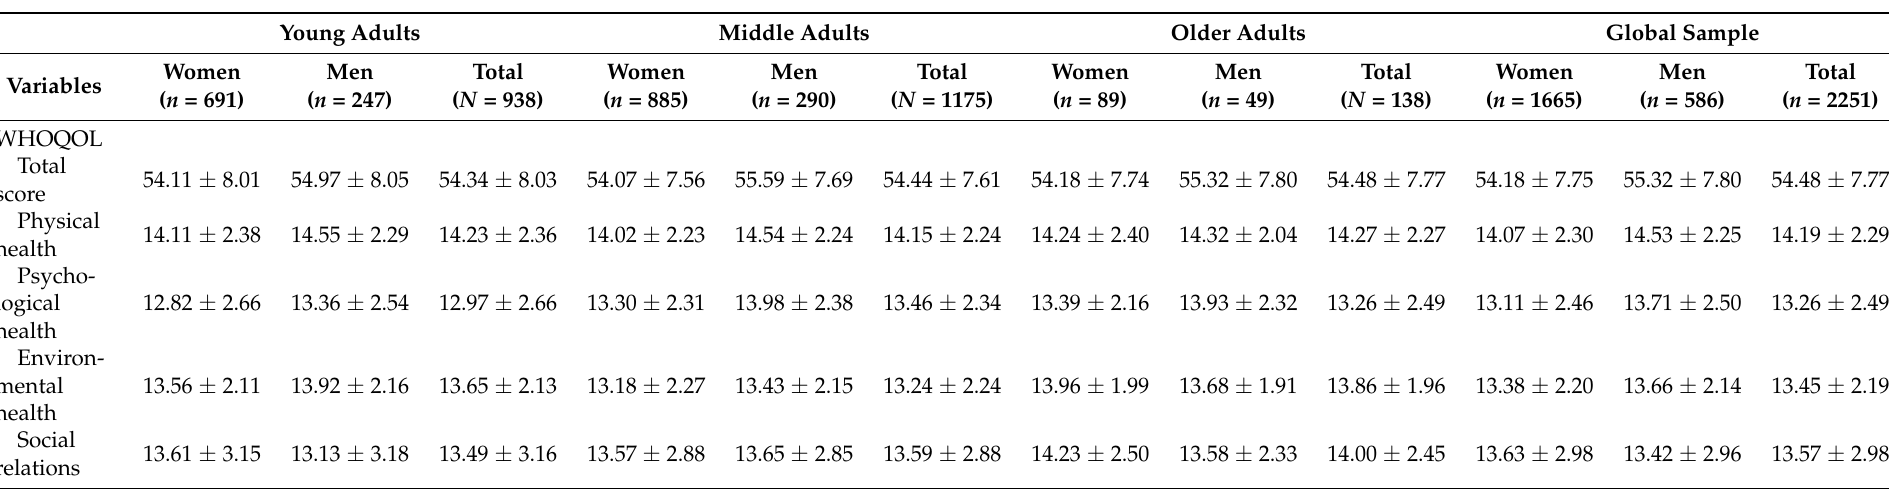
Table 3. Means ± standard deviations of quality of life indicators for all respondents during the outbreak of COVID-19 ( N = 2251) by sex and age range. Young Adults Middle Adults Older Adults Global Sample